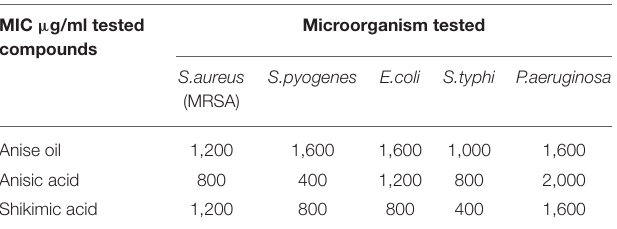
shikimic acid, provided slight antioxidant activities compared to BHT. As the methanol preparation extractive, methyl anisate, possessed significant antioxidant activities. Methyl shikimate, the ethyl acetate extractive, showed the highest